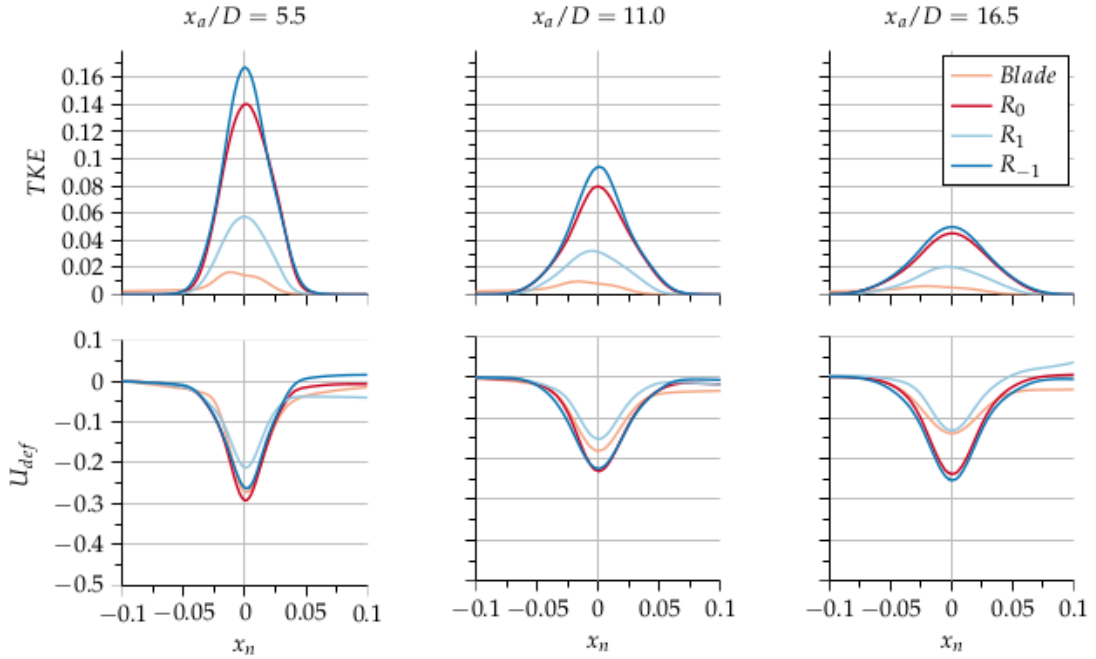
Figure 2. Comparison of the normalised turbulent kinetic energy ( top ) and the velocity deficit ( bottom ) of the bar and blade wakes for different downstream positions. x a and x n denote the axes parallel and perpendicular to the wakes, respectively. The non-rotating bar case is denoted by R 0 , the counter-clockwise rotating bar case by R 1 , the clockwise rotating bar case by R − 1 and the wake off a low pressure turbine (LPT) blade by